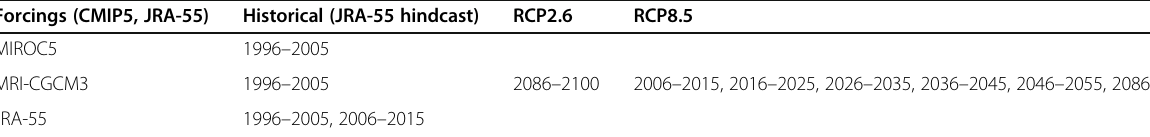
Table 4 Periods of time-sliced downscaling experiments by the JPN02 Forcings (CMIP5, JRA-55)